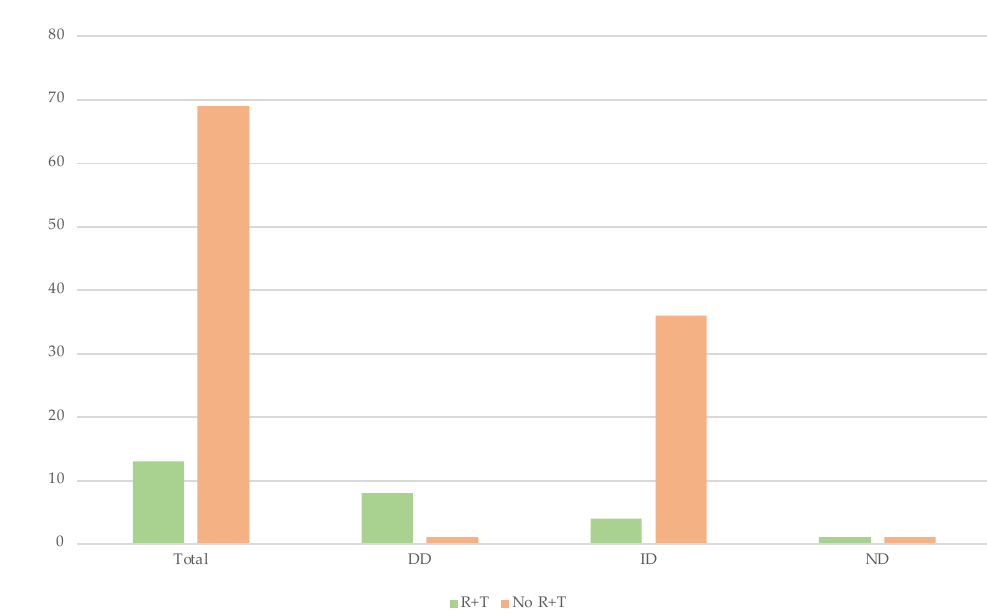
Figure 13. The graph represents all the data described in Table 8. Table 8. The table shows the number of cases (and percentage) of subjects undergoing or not un ‐ dergoing both radiological and toxicological examinations. The data were then matched with di ‐ agnostic findings. Here, DD indicates “direct diagnosis”; ID indicates “indirect diagnosis”; ND in ‐ dicates “undefined”.